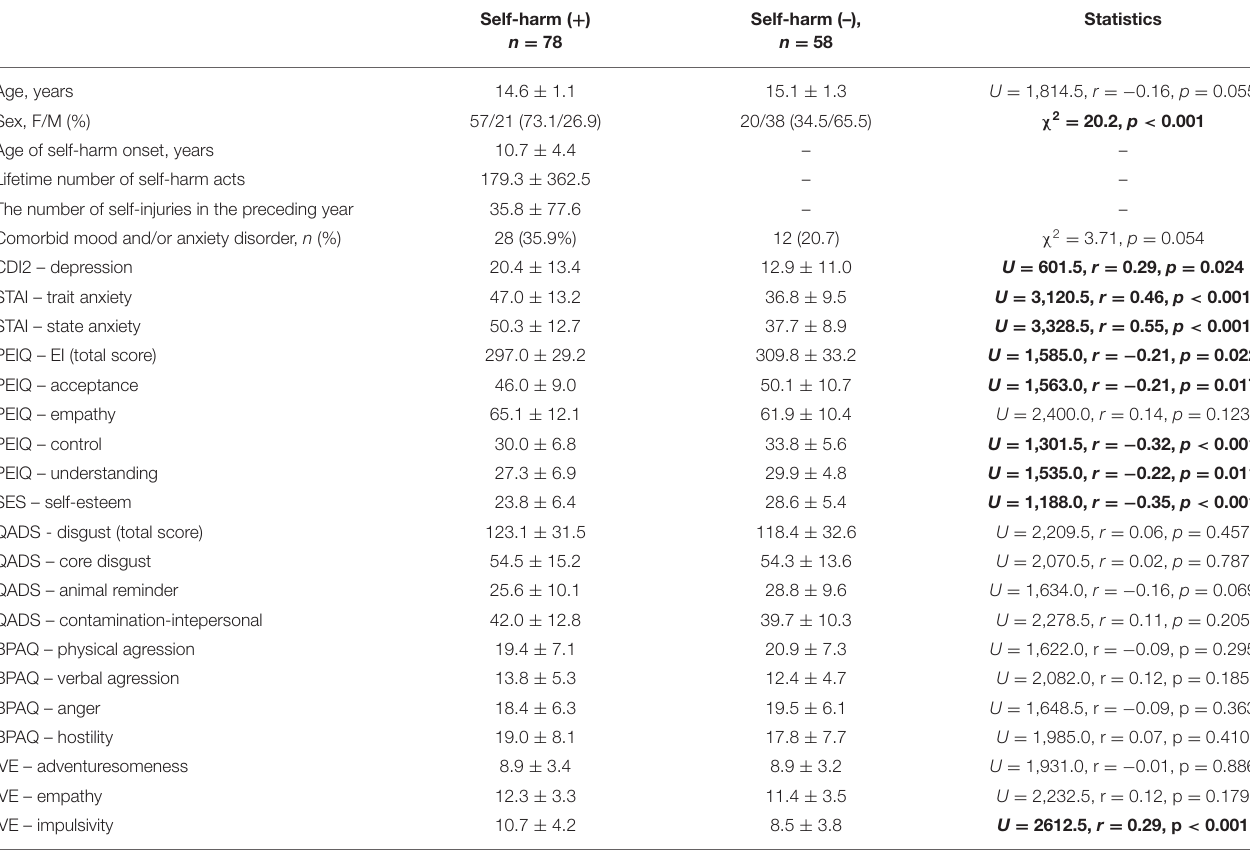
TABLE 1 | General characteristics of the